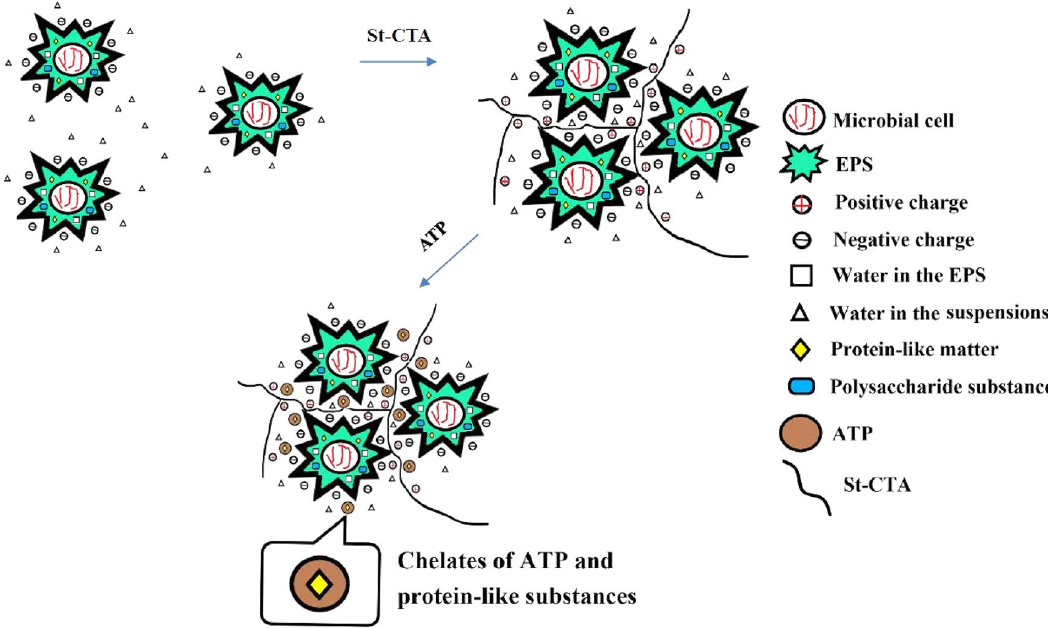
Figure 10. Schematic diagram of the mechanisms in sludge dewatering by the combination of St-CTA and